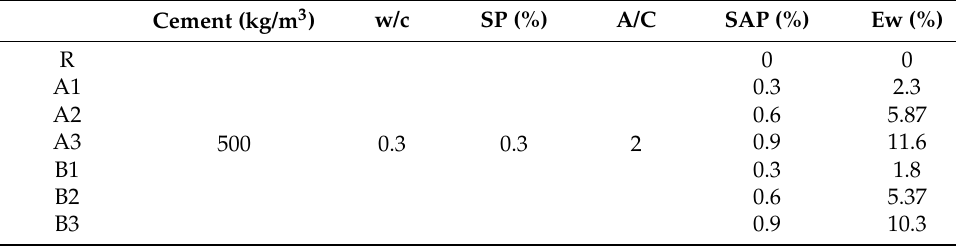
Table 2. Composition of designed cement